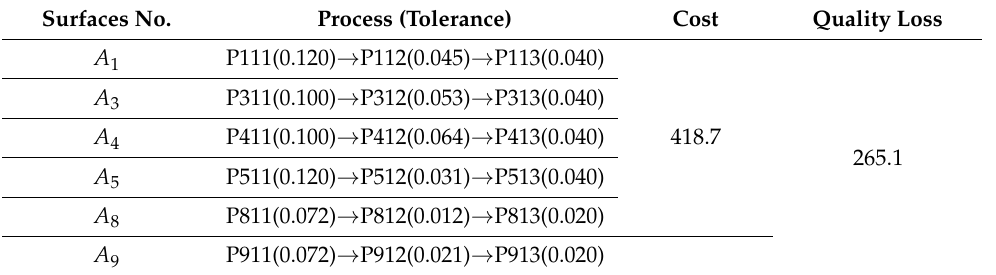
Table 9. Original scheme of a used